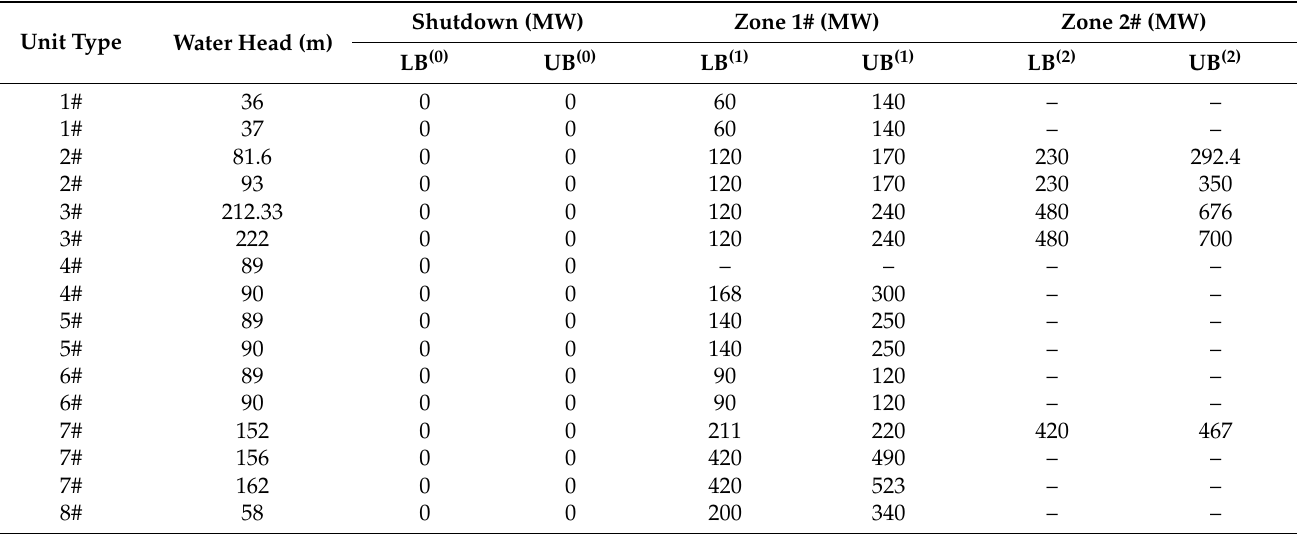
Table 2. Operating zones of the